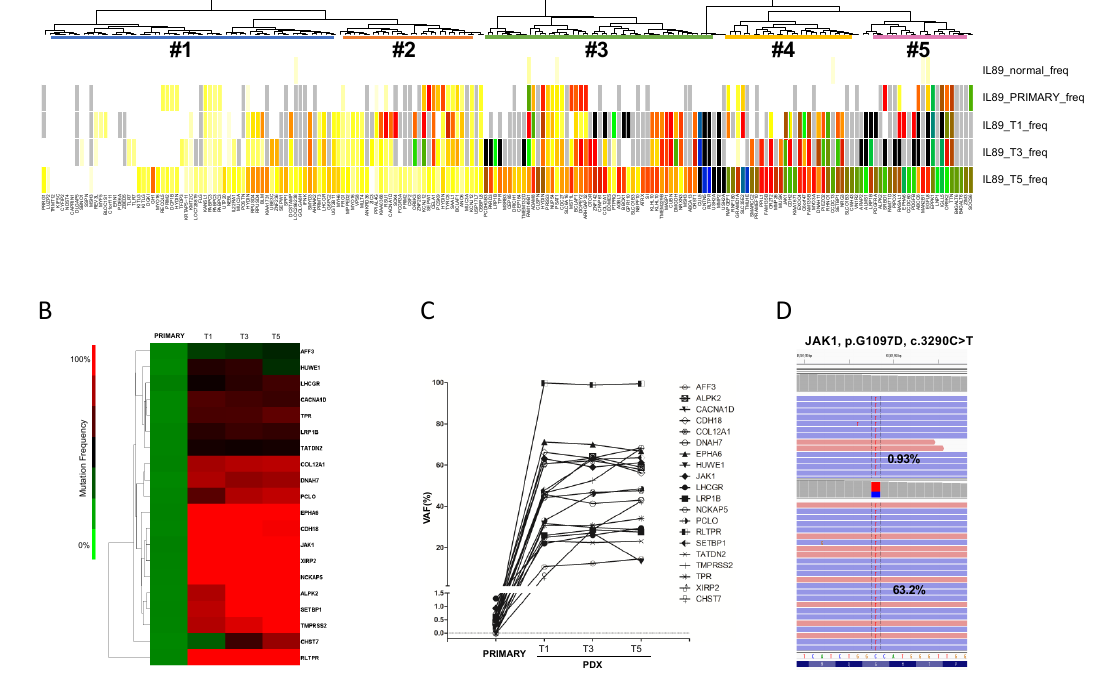
Figure 3. IL89 PDTX clonal evolution in mice. ( A ) Unsupervised hierarchical clustering and relative heatmap of the mutational burden (WES data) of the IL89 diagnostic sample and corresponding PDTX (Passages T1-T3-T5) revealed the presence of five different clusters. The color-code provided is indicative of the VAF. ( B ) Unsupervised hierarchical clustering and relative heatmap of the mutational burden (targeted deep sequencing data) of the IL89 diagnostic sample and corresponding PDTX (passage T1-T3-T5) revealed the presence of five different clusters. The color-code provided is indicative of the VAF. ( C ) Specific VAF enrichment in PDTX (relative to the matched primary sample) of selected mutations analyzed by targeted deep sequencing. ( D ) Manual backtracking of mutations in the primary tumor using deep sequencing data allowed for the identification of the G1097D JAK1 mutation at a very low VAF (0.93%) compared to the PDTX-T1 (63.2%).